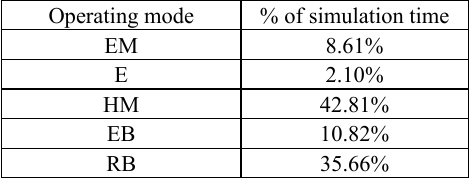
Table 5. Share of simulation time between modes